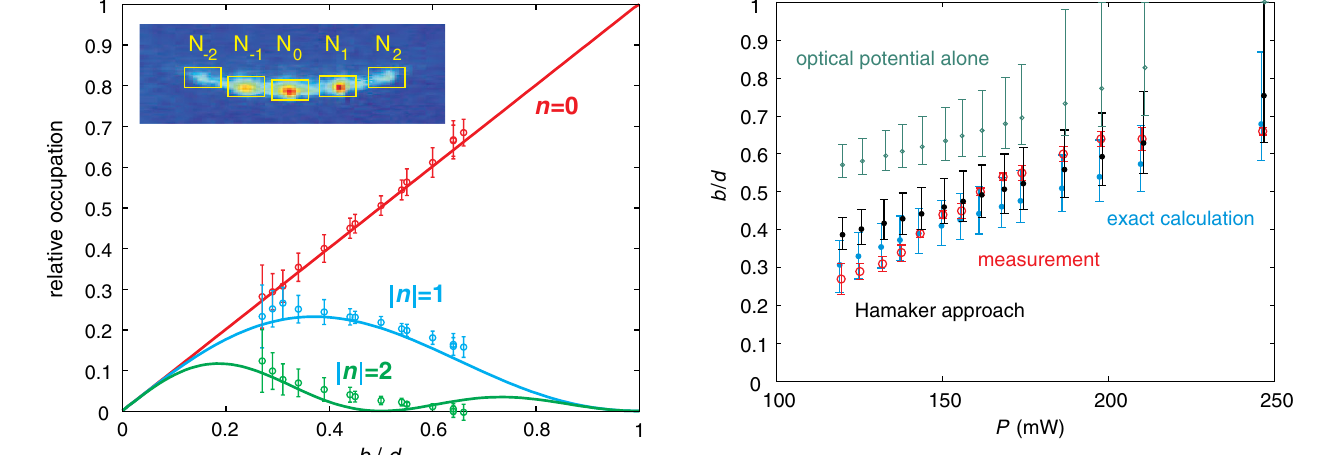
FIG. 3 Matter-wave diffraction. Relative occupation of diffrac- tion orders as a function of the relative width of the reflection zone b=d . The curves are obtained from Eq. (4). Data points represent the measured occupation of diffraction orders as shown in the inset. The horizontal position of each triple of data points (its value b=d ) is obtained from a fit to the theoretical curves.